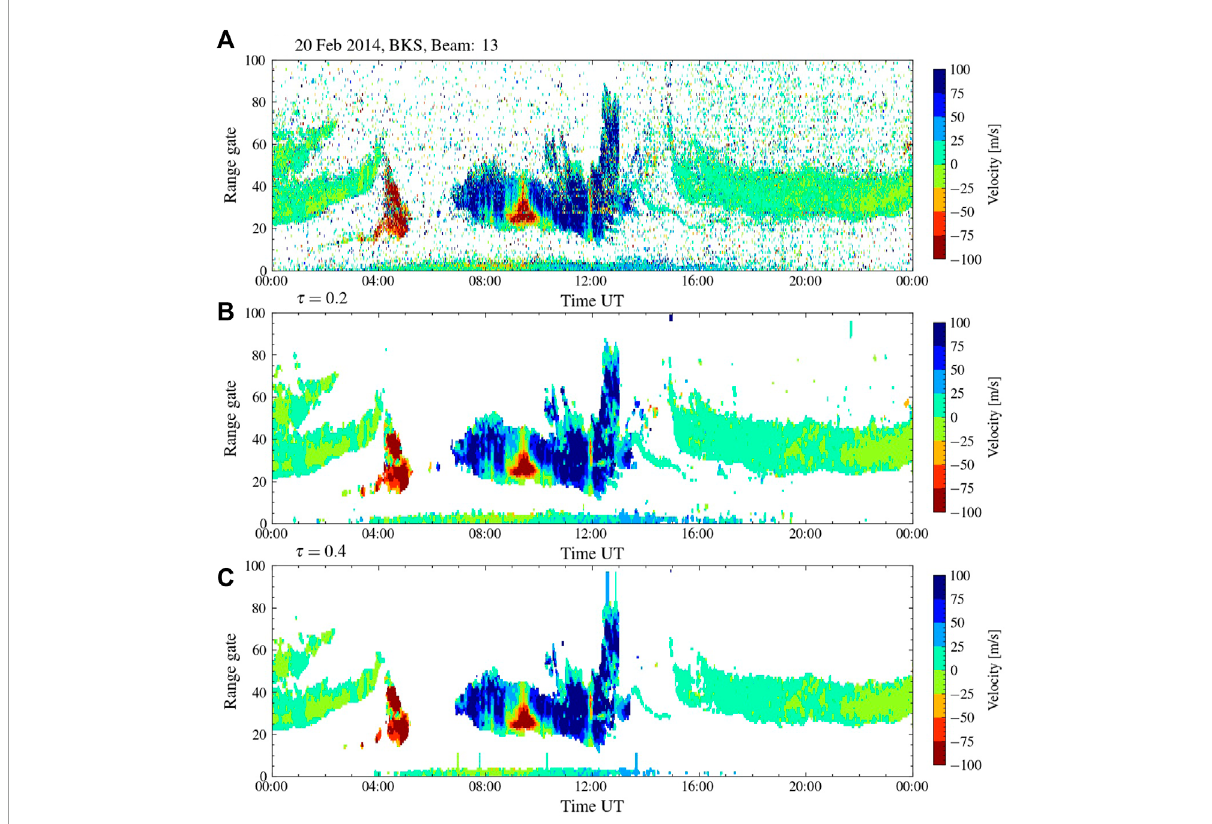
FIGURE 9 RTP plots showing SuperDARN Blackstone radar LoS velocity observations from beam 13 (A) without filtering and filtered using different weights (B) τ = 0 . 2, and (C) τ = 0 . 4 on 20 February